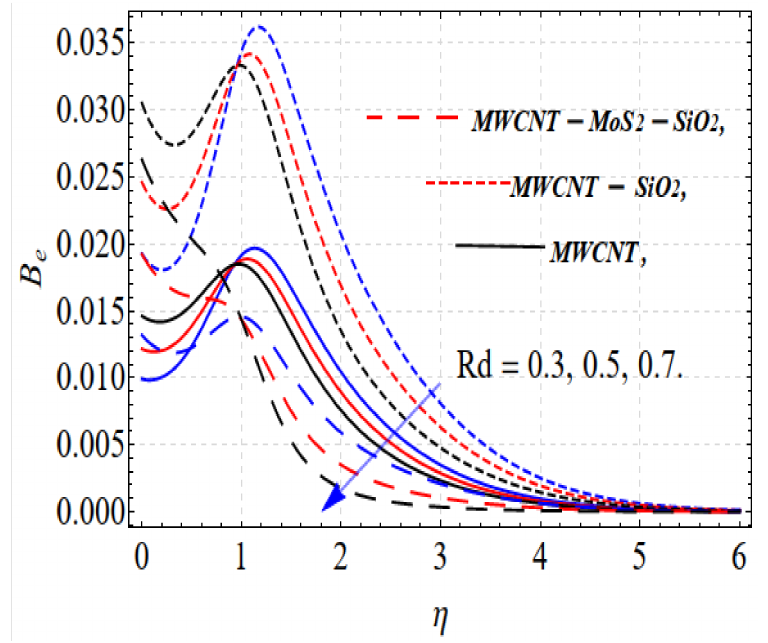
Figure 8. Be vs. Rd